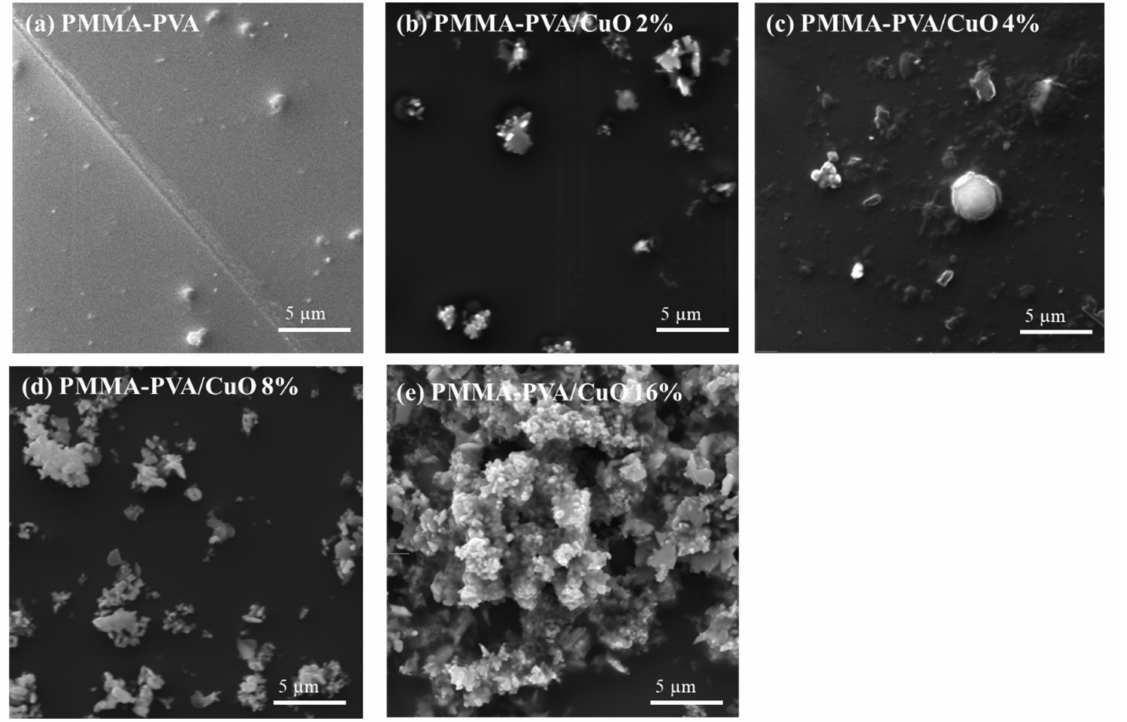
Figure 18. The SEM micrographs of PMMA–PVA/CuO NPs nanocomposite thin films at different concentrations of CuO NPs, ( a ) undoped PMMA–PVA polymer, ( b ) PMMA–PVA/CuO 2% NPs nanocomposite, ( c ) PMMA–PVA/CuO 4% NPs nanocomposite, ( d ) PMMA–PVA/CuO 8% NPs nanocomposite, and ( e ) PMMA–PVA/CuO 16% NPs